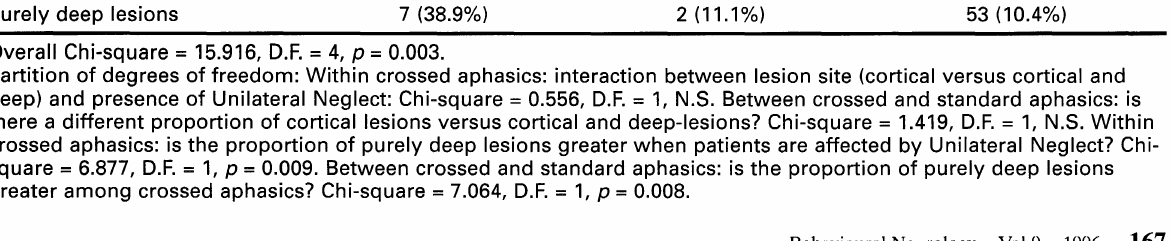
TABLE IV. Analysis of the relationship between lesion site, hemispheric language representation and Unilateral Neglect Crossed aphasics with Unilateral Neglect: n = 18 Cortical lesions Cortical and deep nuclei lesions Purely deep lesions Partition of degrees of freedom: Within crossed aphasics: interaction between lesion site (cortical versus cortical and deep) and presence of Unilateral Neglect: Chi-square = 0.556, D.F. = 1, N.S. Between crossed and standard aphasics: is there a different proportion of cortical lesions versus cortical and deep-lesions? Chi-square = 1.419, D.F. = 1, N.S. Within crossed aphasics: is the proportion of purely deep lesions greater when patients are affected by Unilateral Neglect? Chi square = 6.877, D.F. = 1, p = 0.009. Between crossed and standard aphasics: is the proportion of purely deep lesions greater among crossed aphasics? Chi-square = 7.064, D.F. = 1, P =